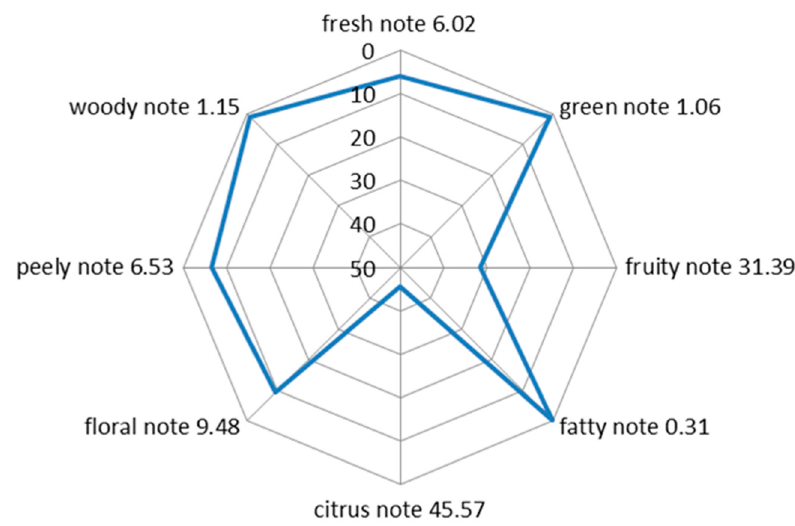
Figure 1. The notes contour of sweet orange flavor (the percentage of aroma notes was larger in the inner concave, but smaller in the outer convex and sharp one). Table 4. The mean intensity values of the eight attributes for the five sweet oranges in descriptive sensory evaluation.